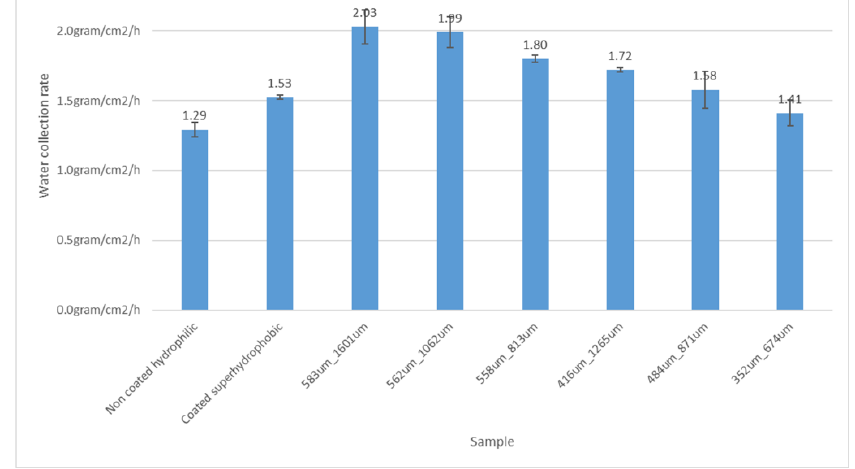
Figure 12: The water collection rate for the samples, including the homogeneous hydrophilic and homogeneous superhydrophobic